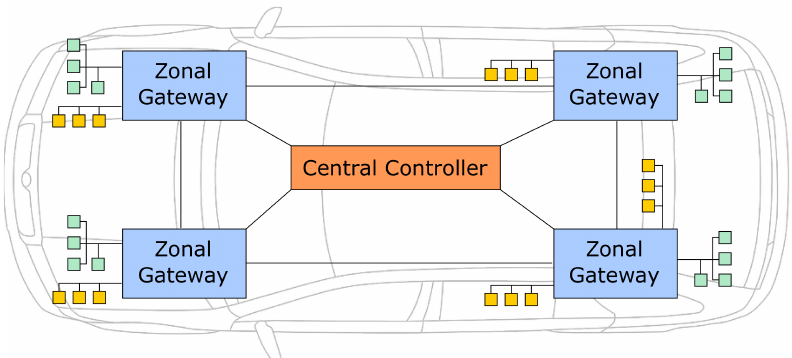
Figure 3. Example of zonal